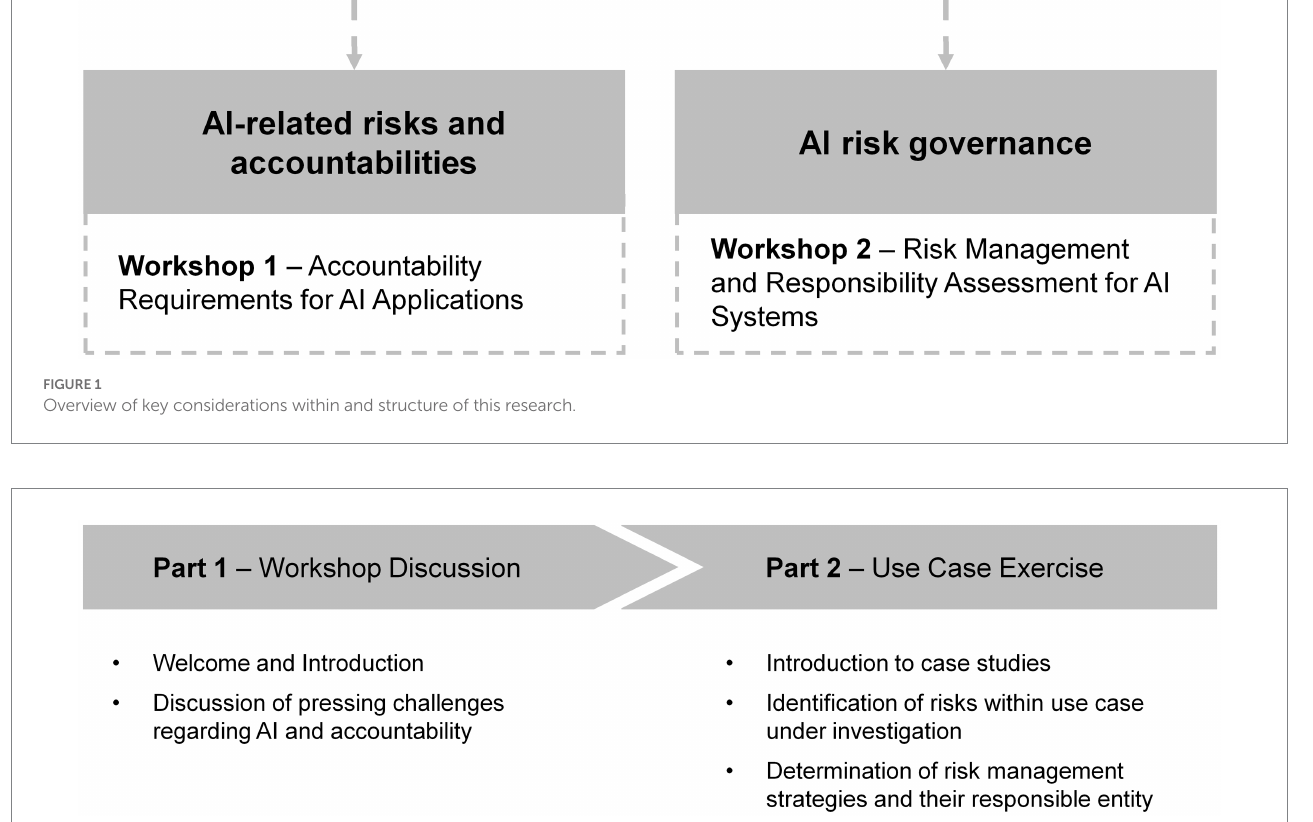
FIGURE 2 Agenda for the ‘Accountability Requirements for AI Applications’